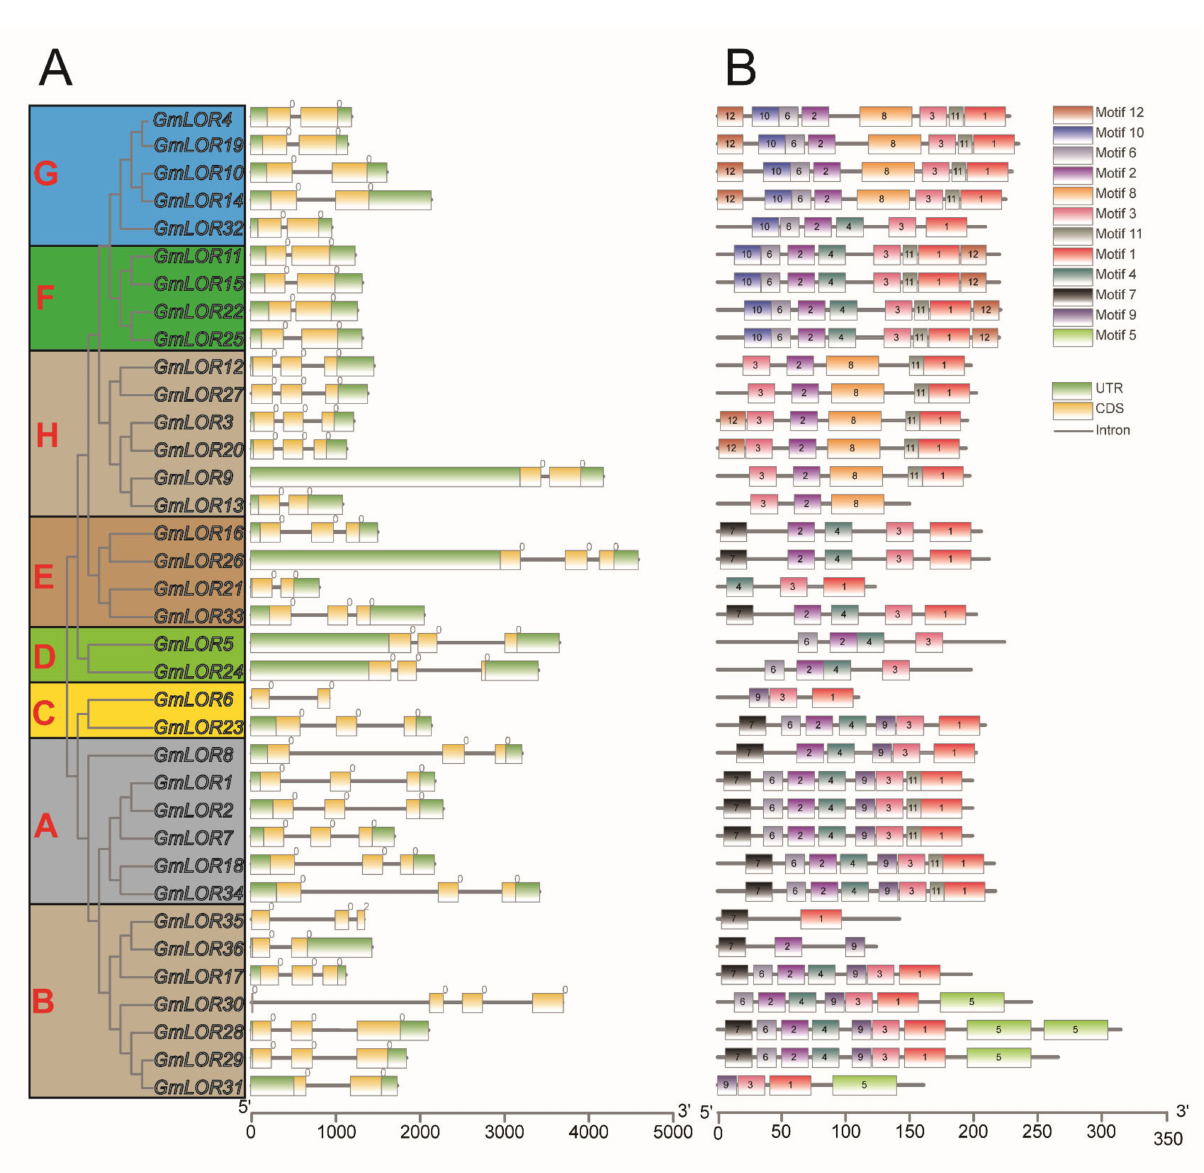
Figure 2. Protein motifs and gene structures of the soybean LOR family. According to the phylogenetic relationships, the GmLOR genes clustered into eight major phylogenetic subgroups ( A ). The exon/intron structures of GmLOR genes. The relative position and size of the exon can be estimated using the scale at the bottom. Yellow boxes, gray lines, and green boxes represent exons, introns, and UTR, respectively ( B ). The putative conserved motifs in GmLORs. Different motifs and their relative positions are represented by the colored